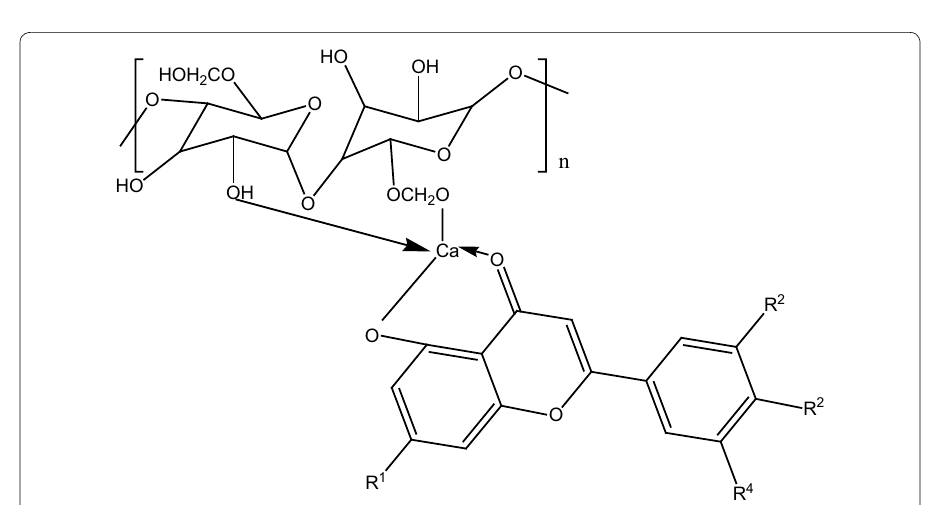
The structures of unmordanted, calcium chloride and alum mordanted B. ferruginea B dyed cellulosic fabrics are shown in Figs. 2, 3 and 4 respectively.